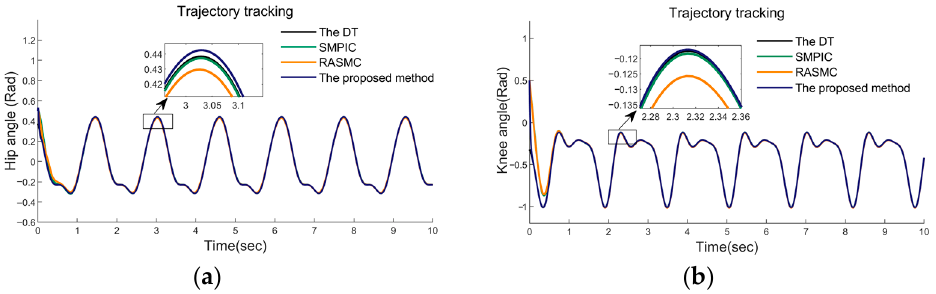
Figure 9. The tracking response of the joints. ( a ) the response of θ 1 under case 1 condition; ( b ) the response of θ 2 under case 1 condition.